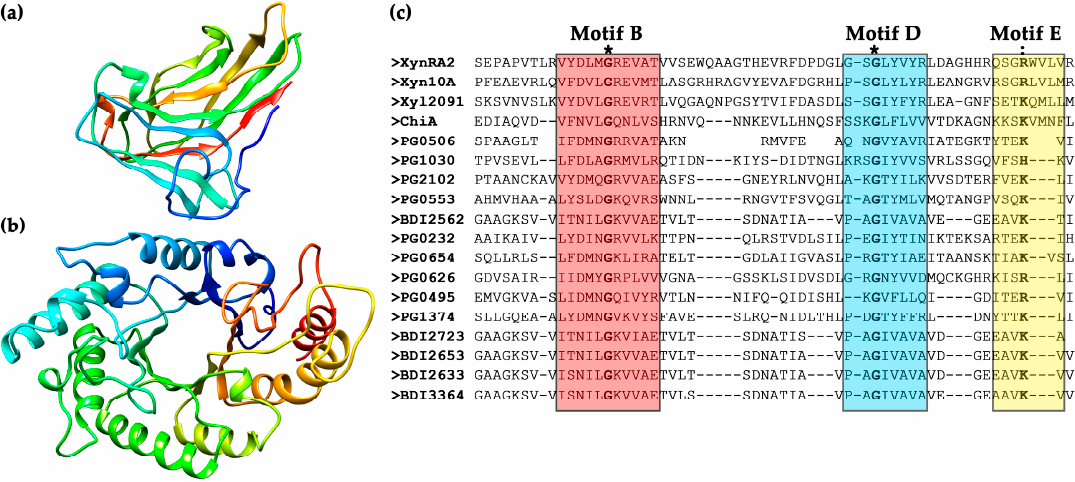
Figure 2. Putative structure of ( a ) CBM4_9 and ( b ) GH10 catalytic domain of XynRA2. The models were colored with the rainbow scheme (blue N-terminus, follows by green, yellow, and red C-terminus); ( c ) multiple sequence alignment of XynRA2 CTD with the counterpart of Xyn10A from R . marinus , Xyl2019 from M . roseus , ChiA from F . johnsoniae , as well as CTD proteins from P . gingivalis and Parabacteroides distasonis . Amino acid stretch for Motif B, D, and E are indicated by red, blue, and yellow boxes, respectively. Asterisks (*) indicate fully conserved amino acids while colon (:) indicates amino acid groups of similar properties.